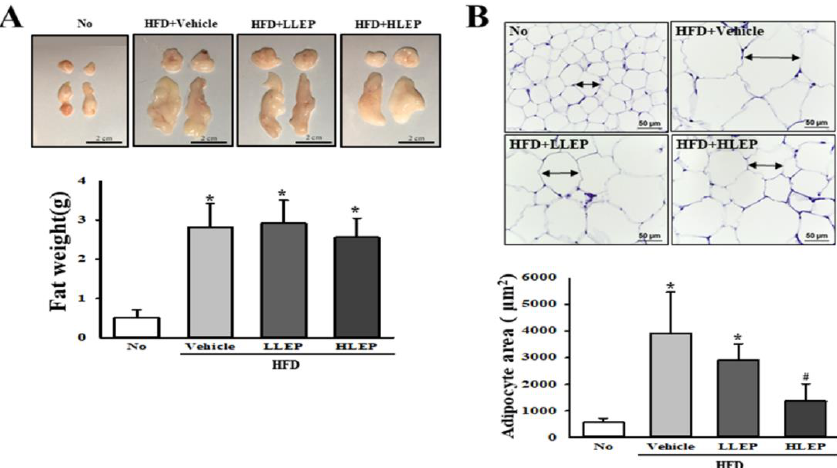
Figure 2. Measurement of fat weight and average area of adipocytes. ( A ) The fat weight is presented by combining the weight of the epididymis and retroperitoneal fat. In the fat image, the upper part indicates the retroperitoneal fat, and the lower part indicates the epididymis fat harvested from the abdominal region of mice of all subset groups. Five to six mice per group were used for the collection of fat tissues; the weight of fat tissue was measured in duplicate for each tissue. ( B ) After taking a photo of the fat tissue at 200× magnification, and the area of each adipocyte was measured using the Image J program. The average area of each adipocyte is also presented as graphs. Five to six mice per group were used for the preparation of H&E stained tissues; the area of adipocytes was measured in duplicate for each slide. Data represent the mean ± SD. * p < 0.05 compared to the No-treated group. # p < 0.05 compared to the HFD + Vehicle-treated group. Abbreviations: HFD, high-fat diet; LLEP,